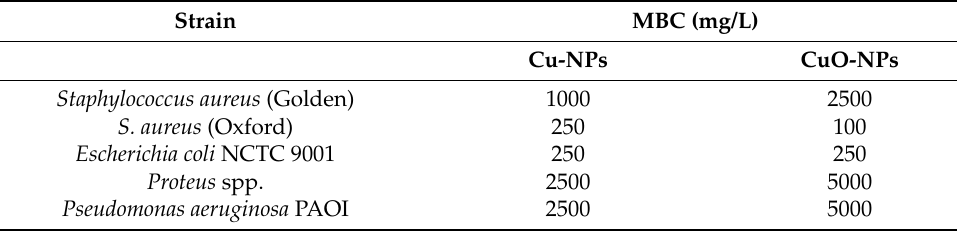
Table 1. MBC of copper and copper oxide nanoparticles per bacteria. Extracted from